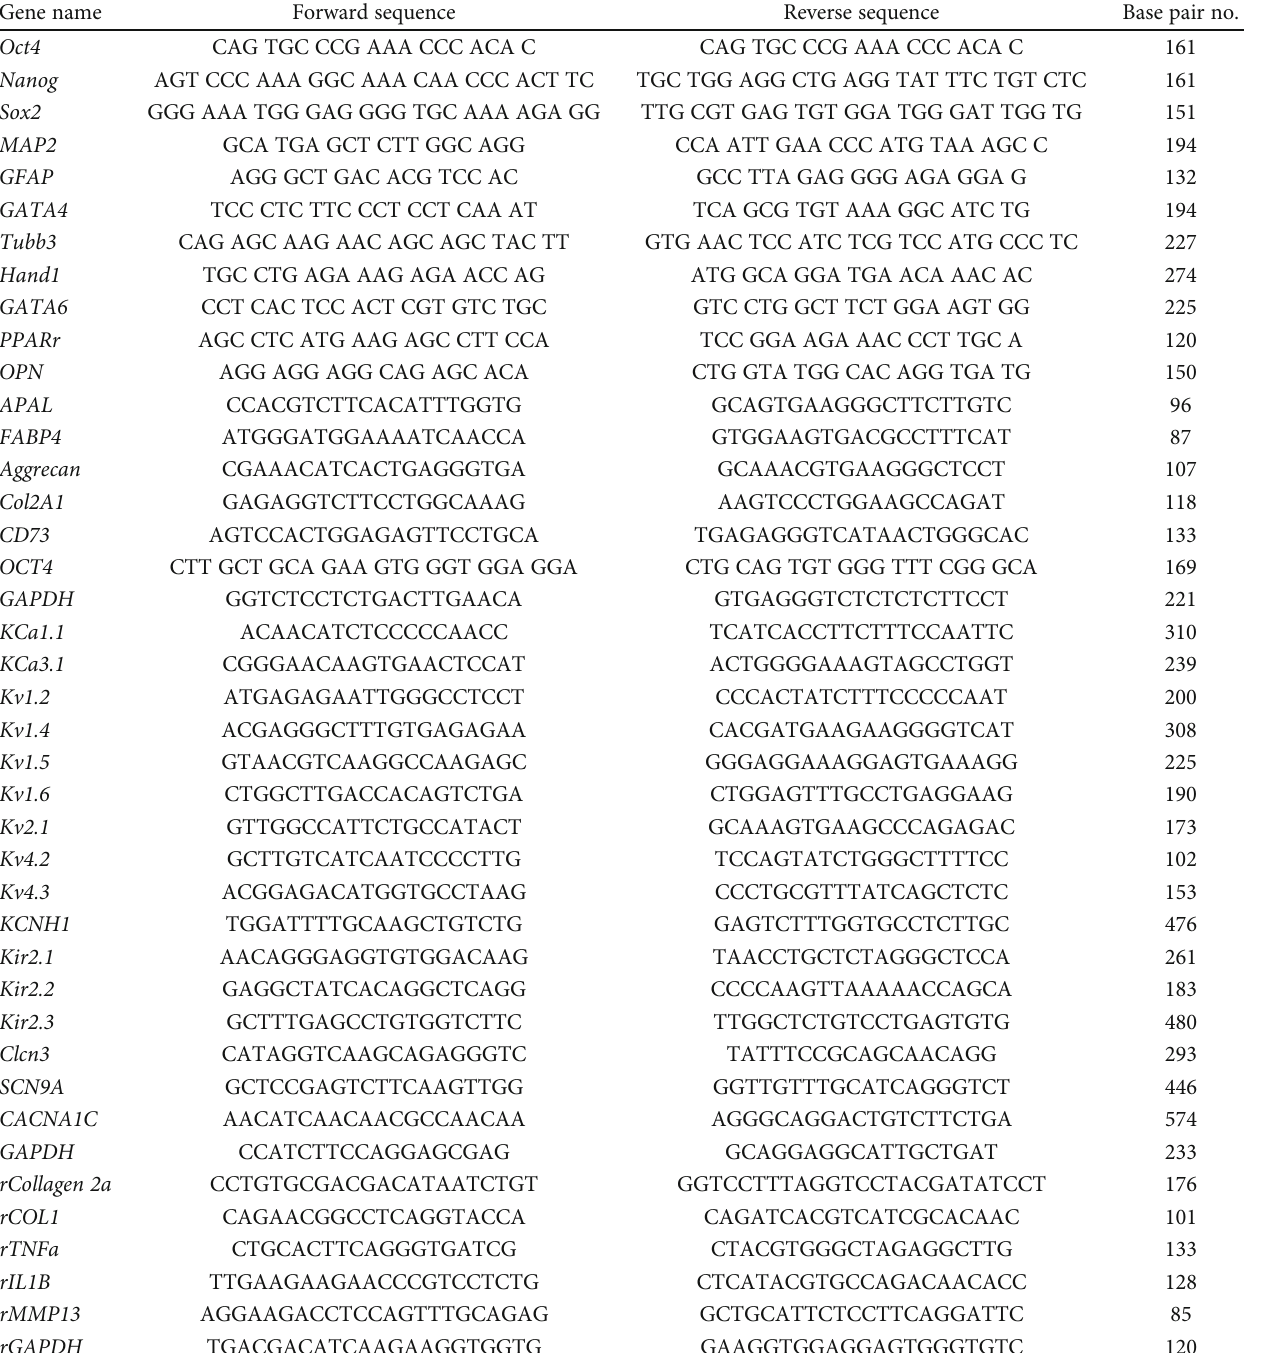
Table 1: Gene primer sequences used for RT-PCR and qPCR